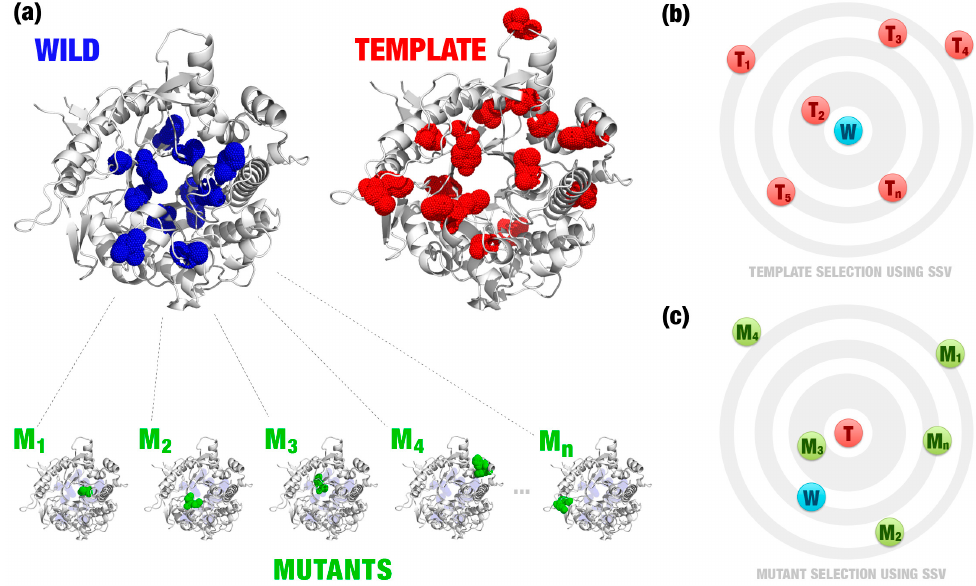
Figure 2. ( a ) Wild and template have a similar folding, but differences in the sequence (illustrated by blue dots in the wild enzyme and by red dots in the template enzyme). Several point mutations were proposed for the wild enzyme (green dots). The template enzyme is defined based on a curated database of enzymes with desired characteristics (in this case study, Betagdb). For instance, in ( b ) the template, T2 was defined as the template (T) for the wild enzyme (W). SSV is illustrated by a two-dimensional visualization in ( b ) and ( c ). Euclidean distances between signatures of the wild/mutants and the template (signature variation) are used to define the best template ( b ) and mutant ( c ). In this example, the mutant, M3, was defined as the mutation that best inserts characteristics similar to the template ( c ). Images generated using PyMOL software